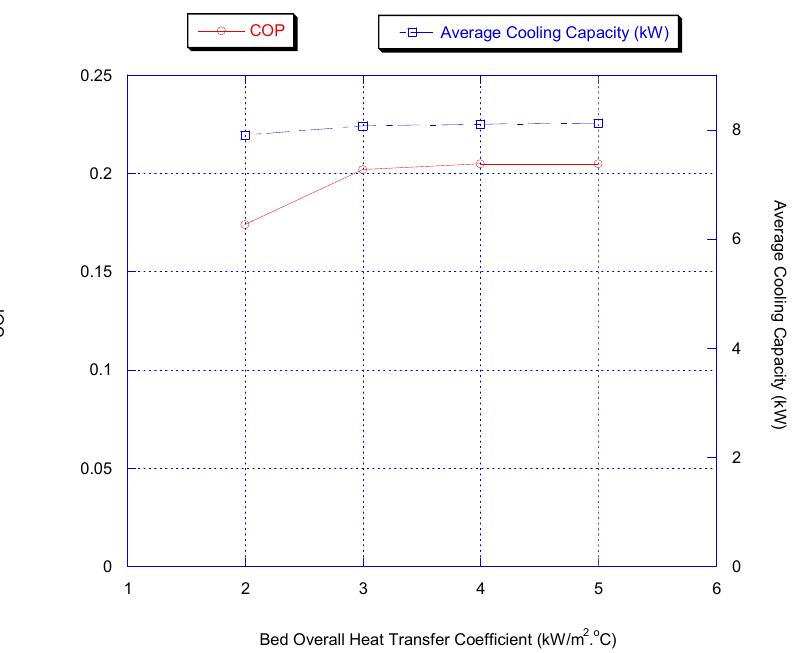
Figure 4. Effect of bed’s overall heat transfer coefficient on chiller average cooling capacity and COP (results are at chiller nominal operating conditions, shown in Appendix B).